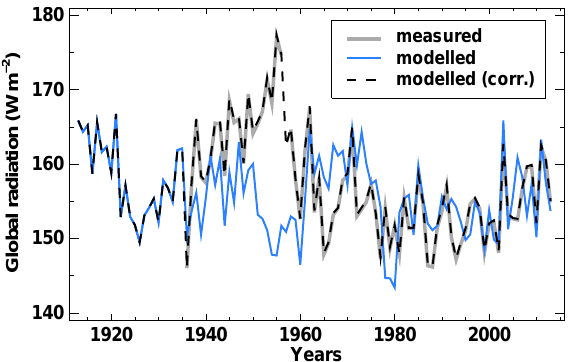
Figure 3. Comparison of mean annual global radiation measured at Davos (bold grey, 1936–2014) and global radiation modeled by the cloud factor parameterization (blue). The dashed black line shows annual averages of modeled daily radiation adjusted by the mea- surements to fit measured monthly means which are used to force the mass balance